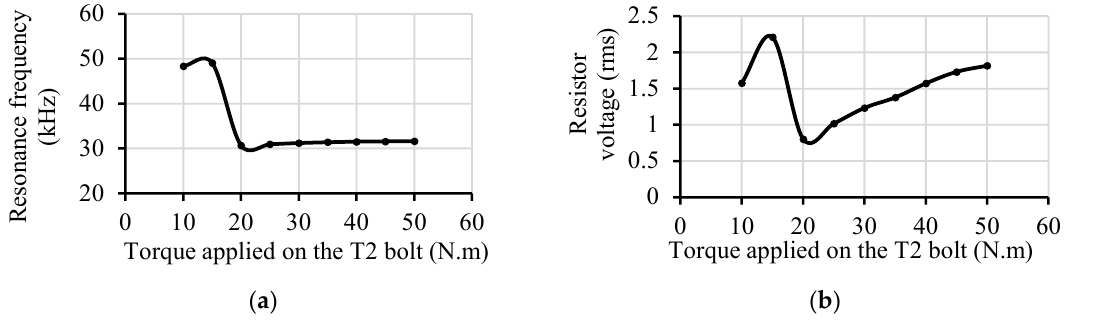
Figure 11. Effect of the applied torque on the bolt over; ( a ) The resonance frequency; and ( b ) The resistor voltage for transducer T2.